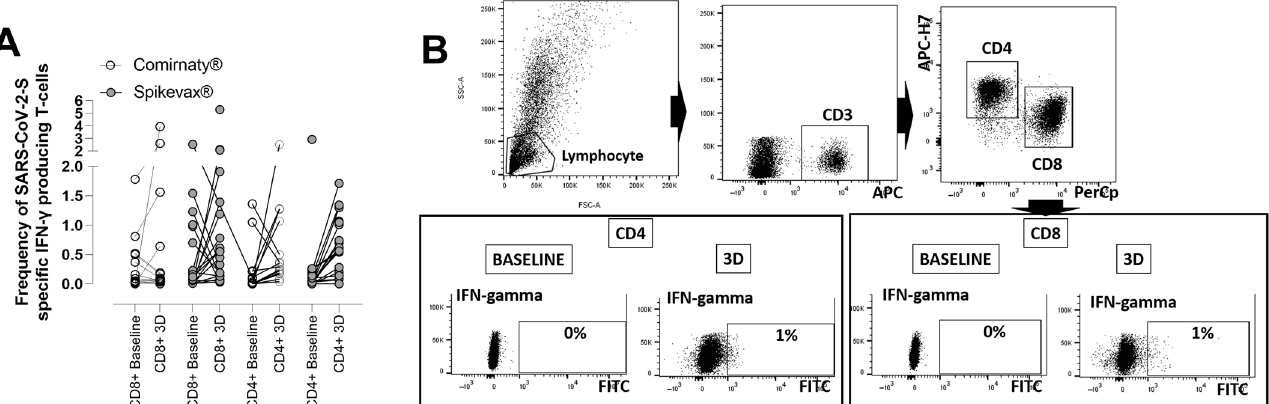
Figure 4. Frequencies of SARS-CoV-2-S- IFN- γ -producing T cells in whole blood as measured by a flow cytometry assay for intracellular cytokine staining in hemodialysis patients ( A ) or kidney trans- plant recipients ( B ) after receipt of a homologous mRNA COVID-19 third dose (3D) relative to those measured at baseline; p -values for comparisons across groups are shown.